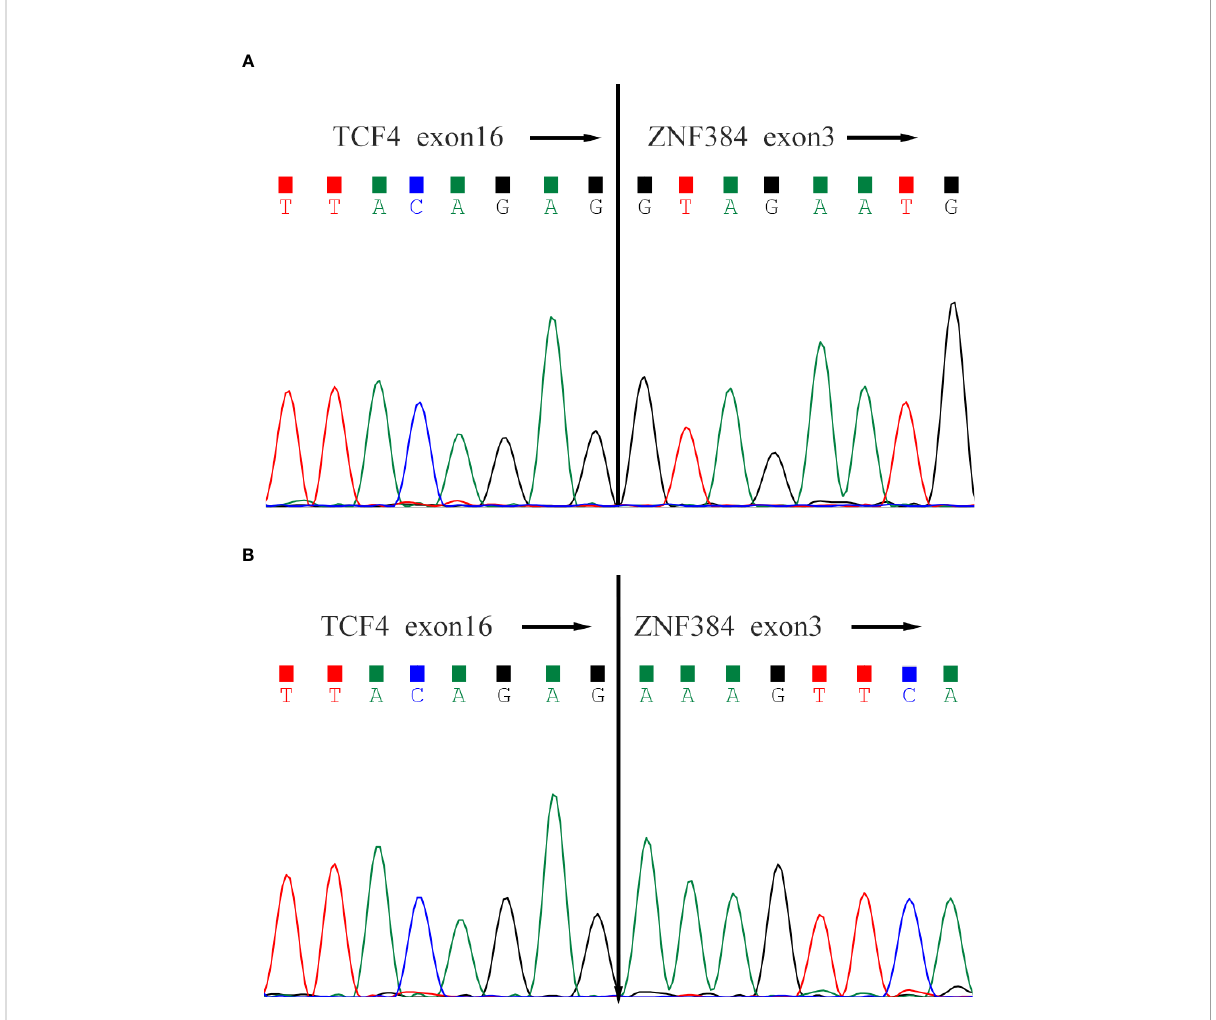
FIGURE 1 Sanger sequencing of the TCF4-ZNF384 fusion transcript. Both patients' breakpoints were located at exon 16 of TCF4 and exon 3 of ZNF384, (A) for Case-1 and (B) for